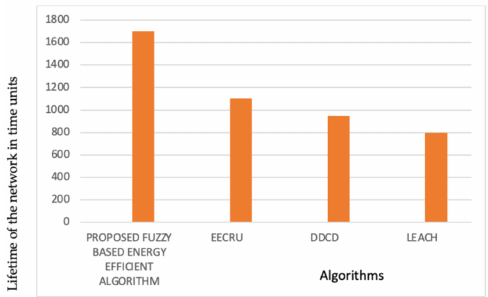
Figure 3. Comparison of the proposed algorithm with EECRU, DDCD, and LEACH